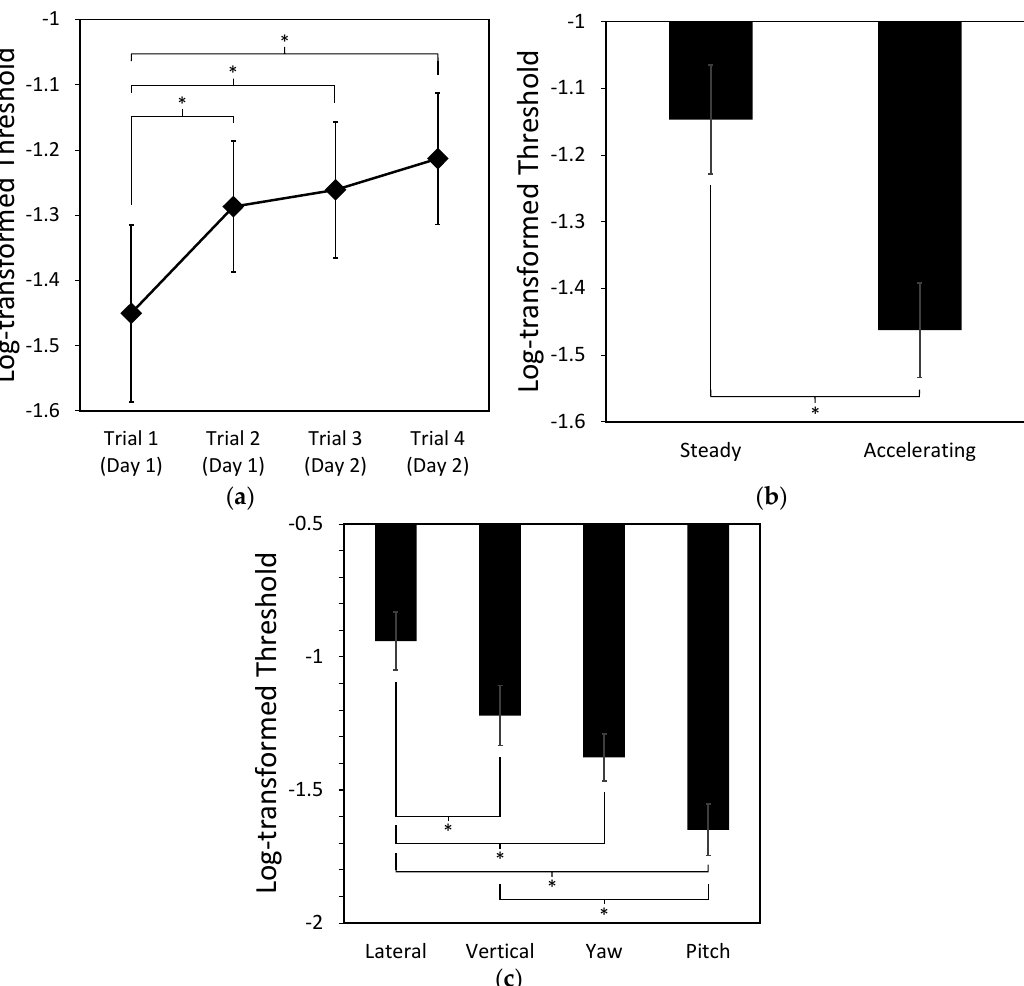
Figure 3. Plot of ANOVA results for log-transformed thresholds: ( a ) between repetitions; ( b ) between types of motion; ( c ) between scene movements. The error bars represent 95% confidence intervals for each condition. The * represents p < 0.05 for the statistical significance.